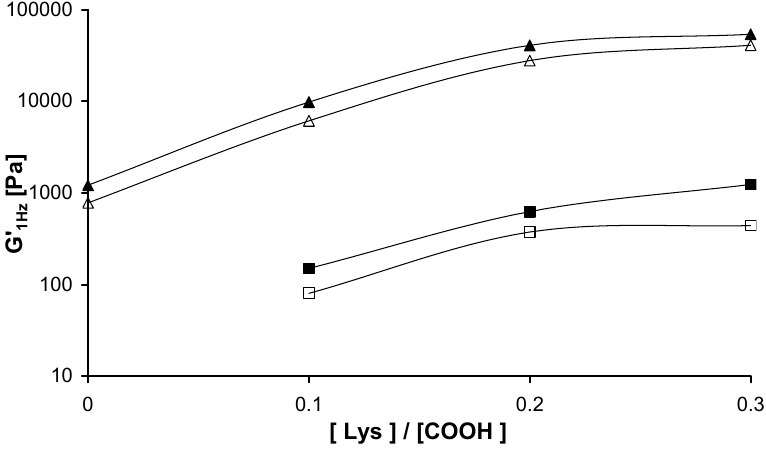
Figure 5. G’(1 Hz) at 25 °C (full symbols) and 37 °C (empty symbols) for the chemical Gellan hydrogel (squares) and physical Gellan hydrogels